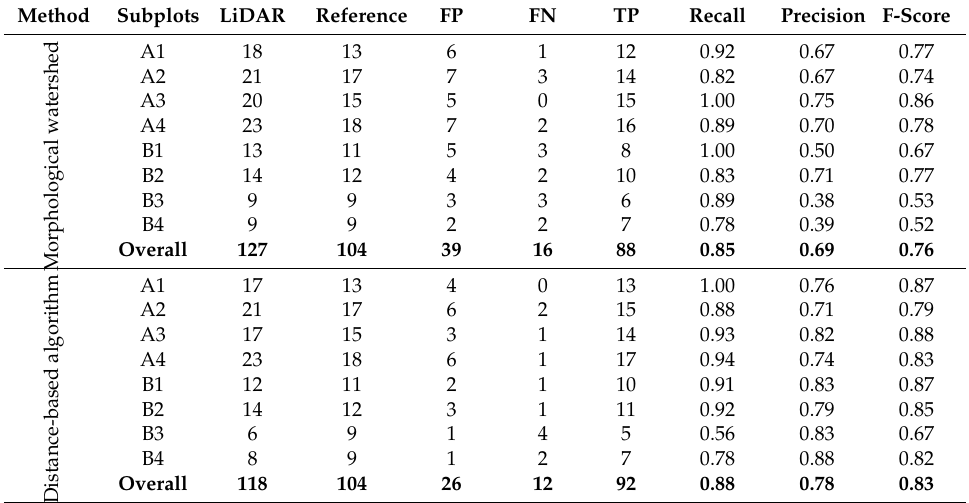
Table 3. Accuracy assessment statistics for tree segmentation using morphological